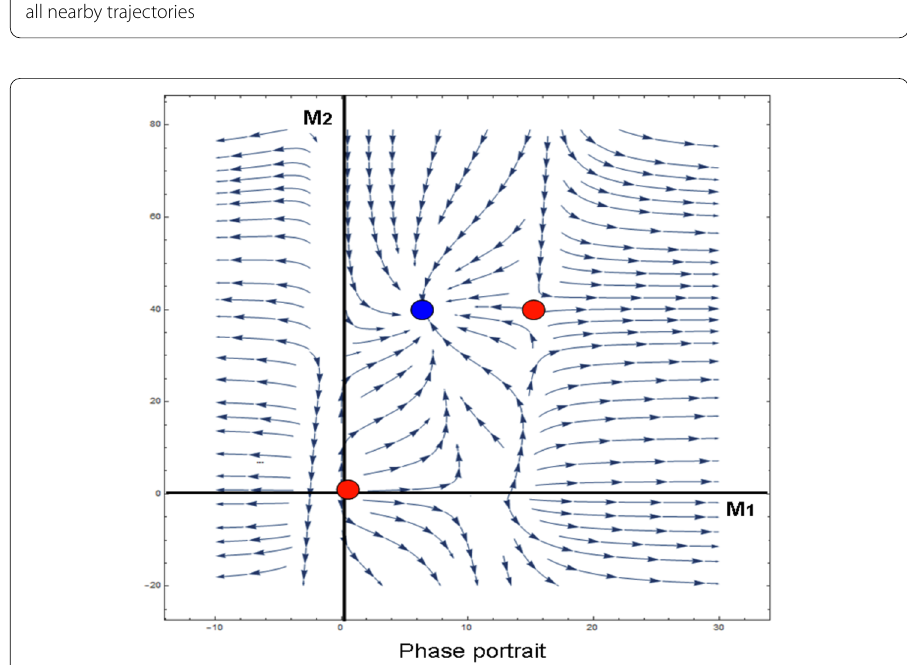
Figure 2 Phase portrait when the system admits one stable positive equilibrium point attracting nearby trajectories and one positive unstable equilibrium behaving as a saddle node